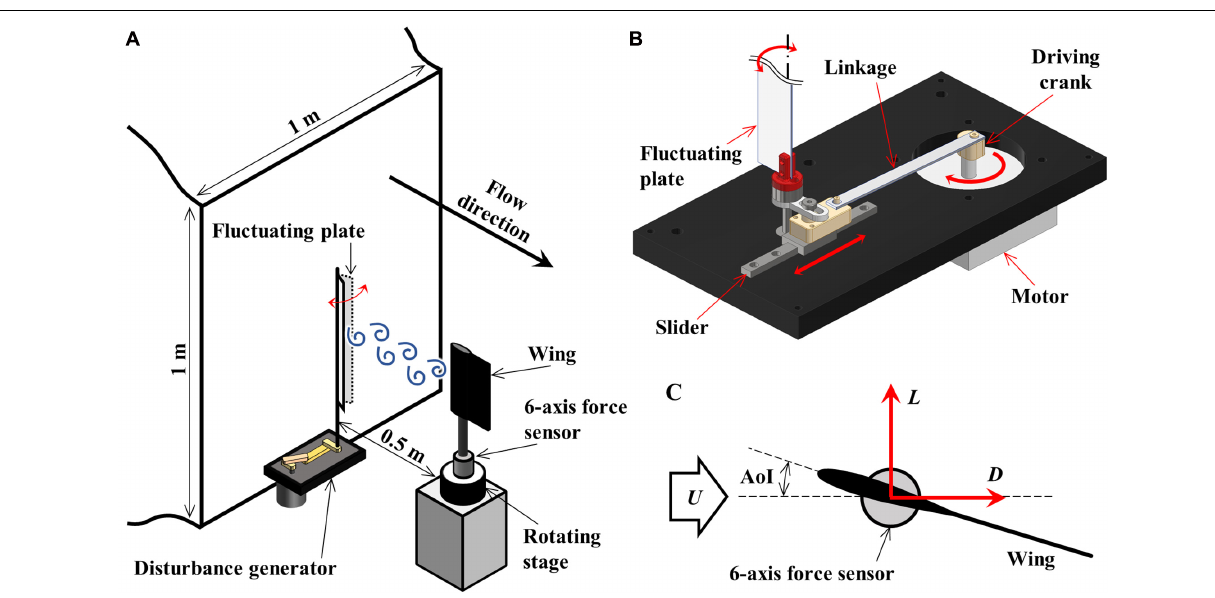
FIGURE 2 | (A) Experimental setup for aerodynamic force measurements in the low-speed wind tunnel. The fluctuation generator was mounted upstream for measurements in disturbed flow. (B) The fluctuation plate was driven by a motor via a slider-crank mechanism. (C) Lift, L, and Drag, D, were measured by the 6-axis force